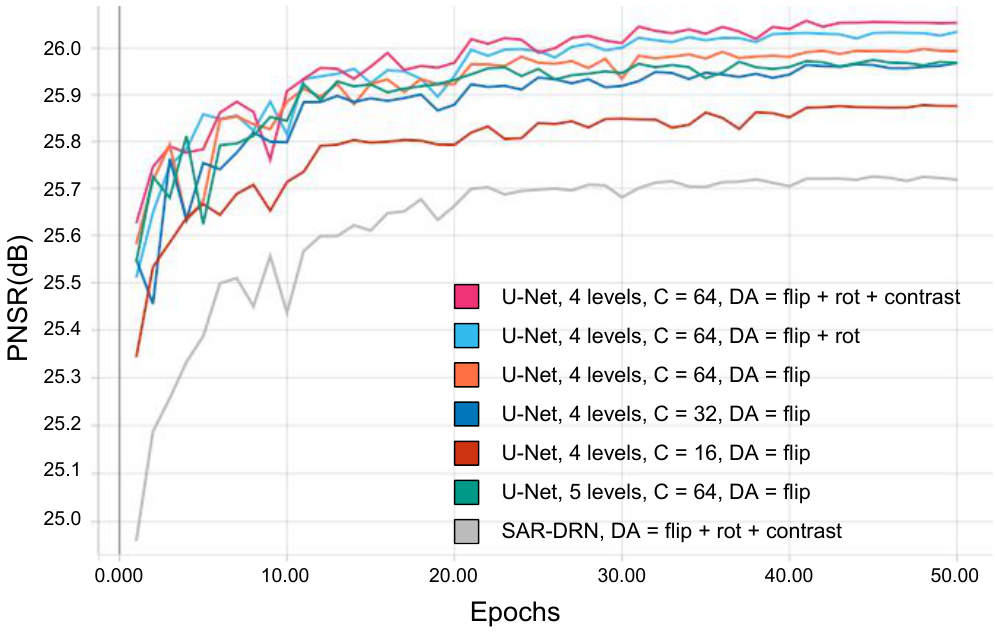
Figure 7. Ablation: network configurations and data augmentation. Table 4. Ablation study on skip connections: SSIM computed on test set.